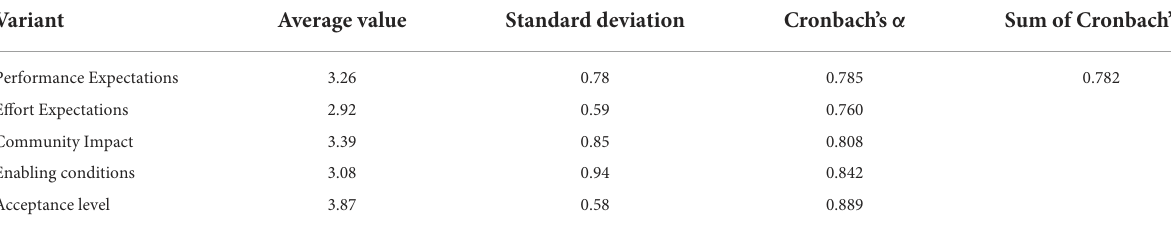
TABLE 3 Descriptive statistical analysis of model